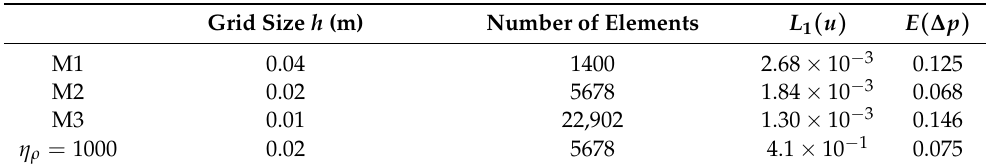
Table 1. Mesh data and results for the mesh sensitivity study and for the η ρ = 1000 case, simulated with the M2